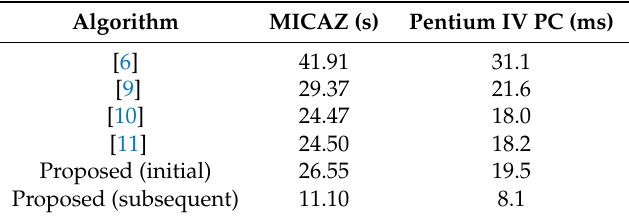
Table 5. Computational times of various algorithms.